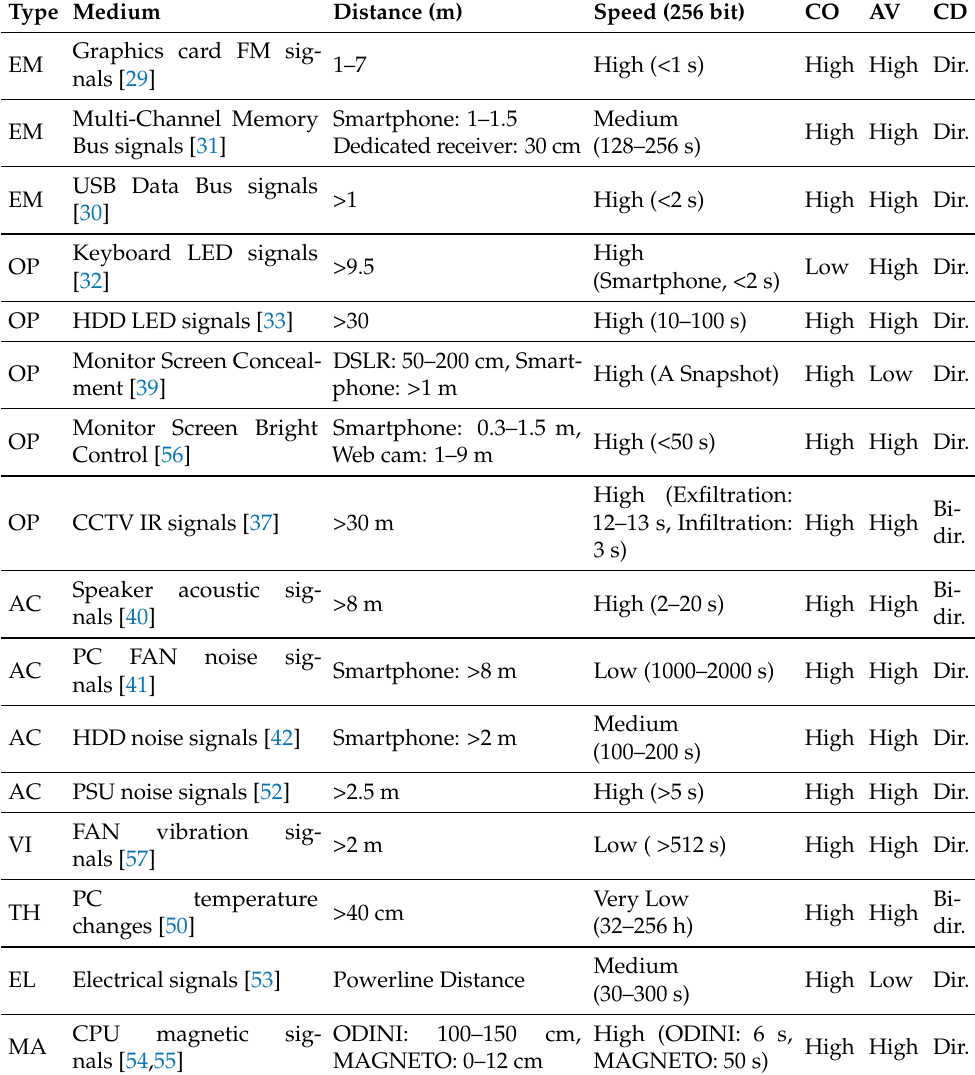
Table 2. Characteristics of air-gap attacks for each transmission medium (EM: Electromagnetic; OP: Optical; AC: Acoustic; VI: Vibration; TH: Thermal; MA: Magnetic; CO: Covertness; AV: Availability; CD: Communication